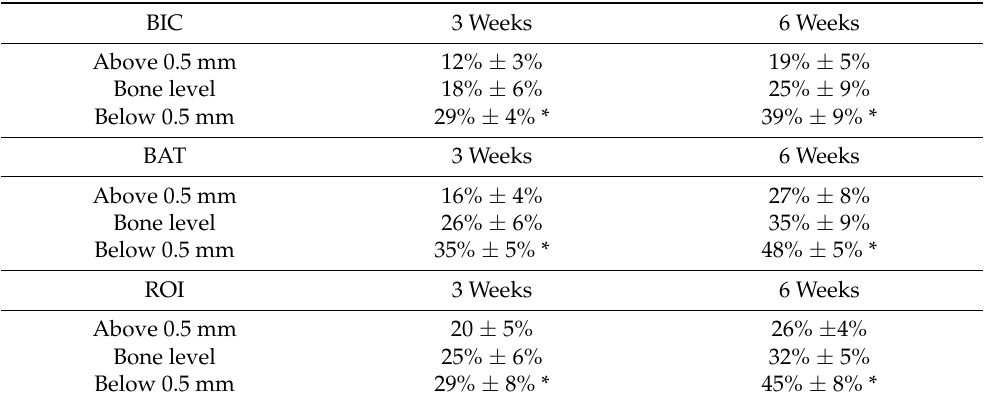
Table 3. Bone index contact (BIC), total bone area (BAT) and region of interest bone growth (ROI) for different types of Ti dental implant surfaces after 3 or 6 weeks of implantation. Cortical thick- ness of 1.5 mm. Statistical differences for each column are indicated by single asterisk ( p < 0.05). Thickness: 2.5